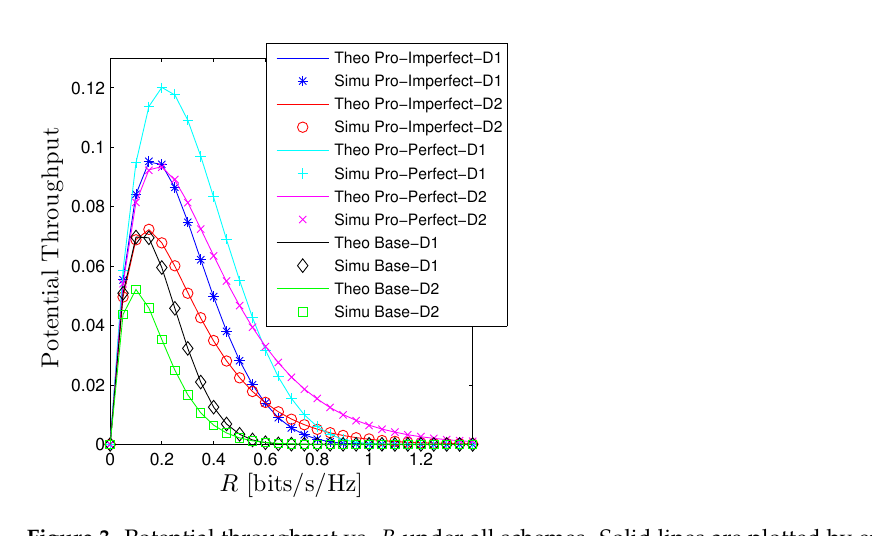
Figure 3. Potential throughput vs. R under all schemes. Solid lines are plotted by employing (13) while markers are Monte Carlo